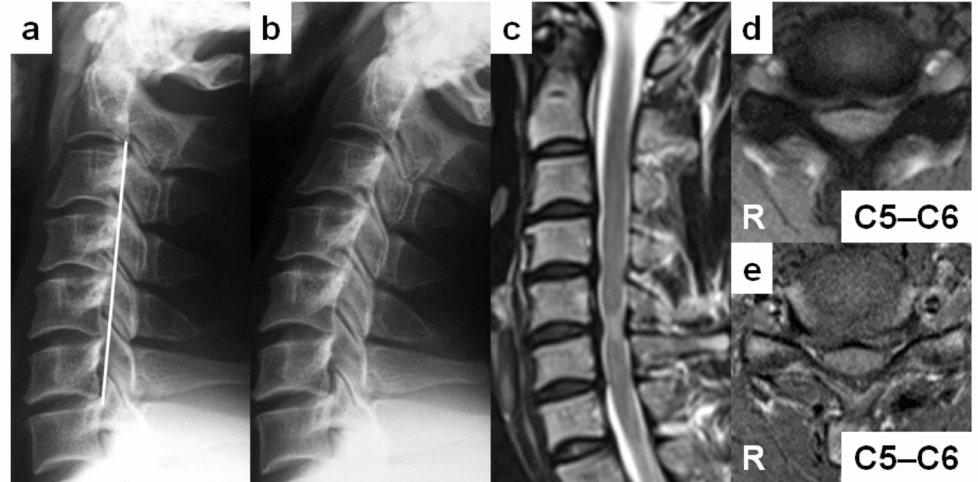
Figure 2. Report of a 27-year-old man with cervical spondylotic myelopathy (case no. 1). ( a , b ) Lateral cervical spine radiographs in neutral ( a ) and full-extension ( b ) positions demonstrating the “straight” cervical sagittal alignment. ( c ) A sagittal T2-weighted magnetic resonance image (MRI) demonstrating “degenerative” discs from C3–C4 to C6–C7, spinal cord compression from C4–C5 to C6–C7, and an intramedullary increased signal intensity lesion at C5–C6. ( d ) An axial T2-weighted MRI demonstrating the narrowed cervical spinal canal with an intramedullary increased signal intensity area at C5–C6. ( e ) An axial T1-weighted MRI demonstrating the “angular-edged” spinal cord deformity at